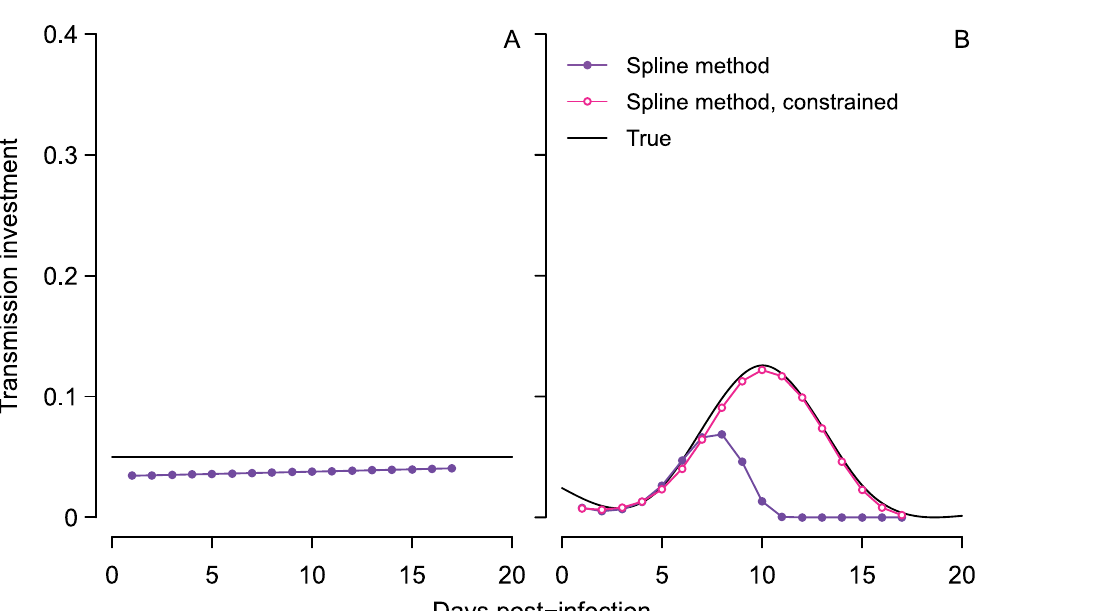
Fig 3. The spline method performs better than previous methods in capturing the true pattern of transmission investment. The true pattern is shown in black for constant (A) and variable (B) investment, while the spline estimate is indicated with closed purple circles for comparison to previous methods in Fig 2A and 2B. The gametocyte carryover ( (cid:2) ) corresponding to those estimated splines was 28% in (A), and 42% in (B), where the true value was 30%. In (B), constraining the gametocyte carryover to be less than 35% improved the spline fit (open pink circles), an improvement that is not possible for previous methods which do not account for